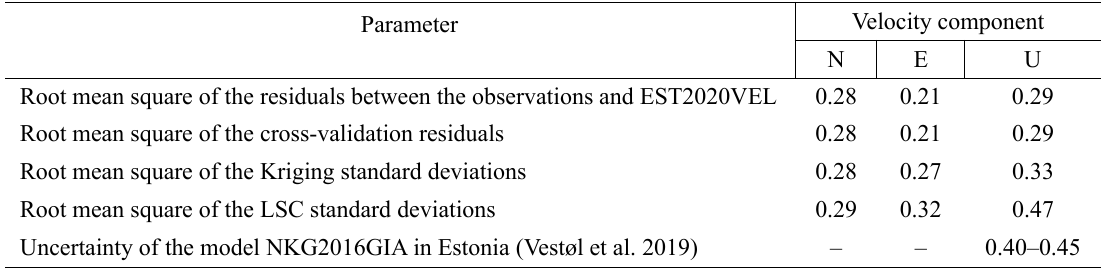
Table 8. Estimates of the uncertainty of EST2020VEL in North (N), East (E) and Up (U) directions. Unit is mm/a